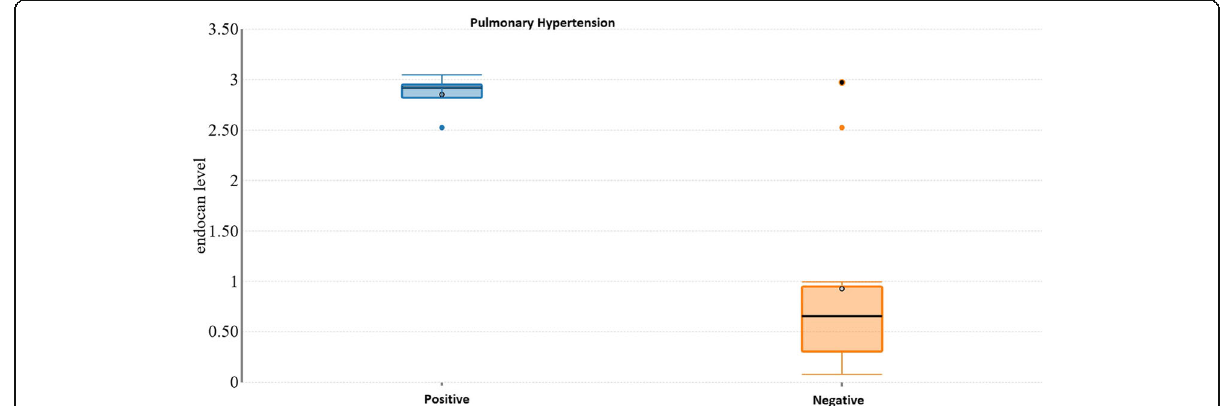
Fig. 1 Box plot of endocan level in patients with and without pulmonary hypertension